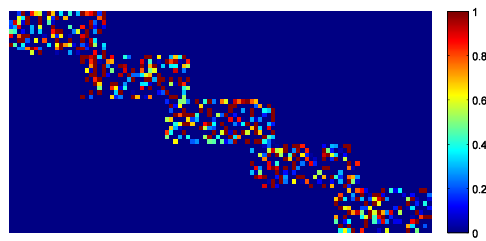
Figure 3. Illustration of a block diagonal 𝚽 resulted from applying the proposed segmented sampling. Notice the overlapping between the blocks for avoiding information loss.